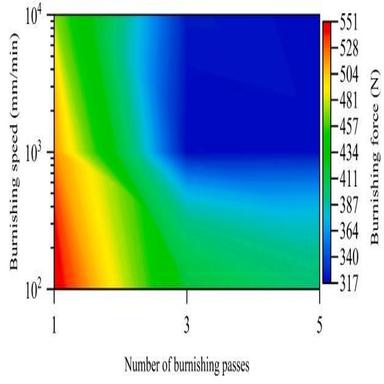
Influence of the burnishing speed and number of passes on the burnishing force.